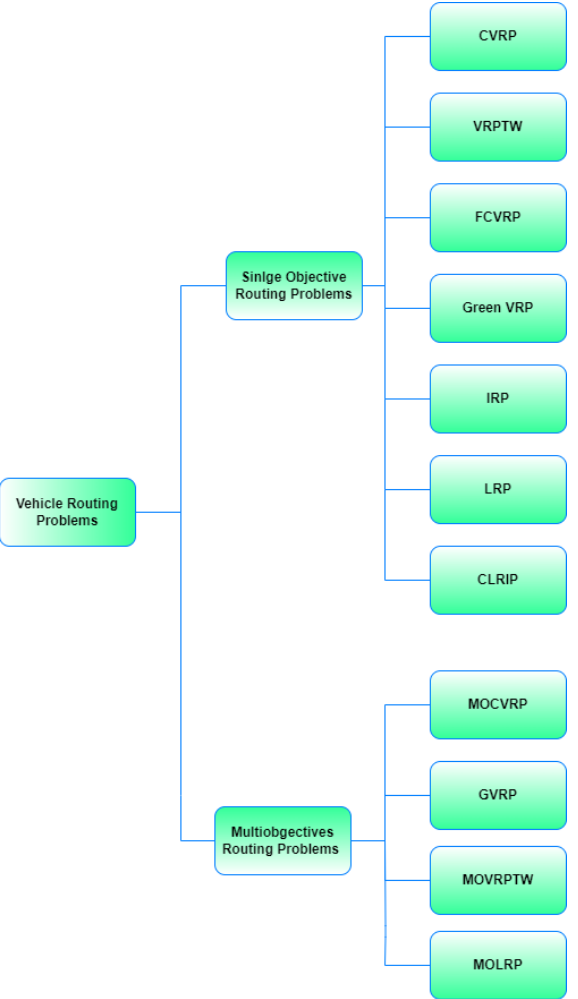
Figure 1. Categorization of the referred single-objective and multiobjective